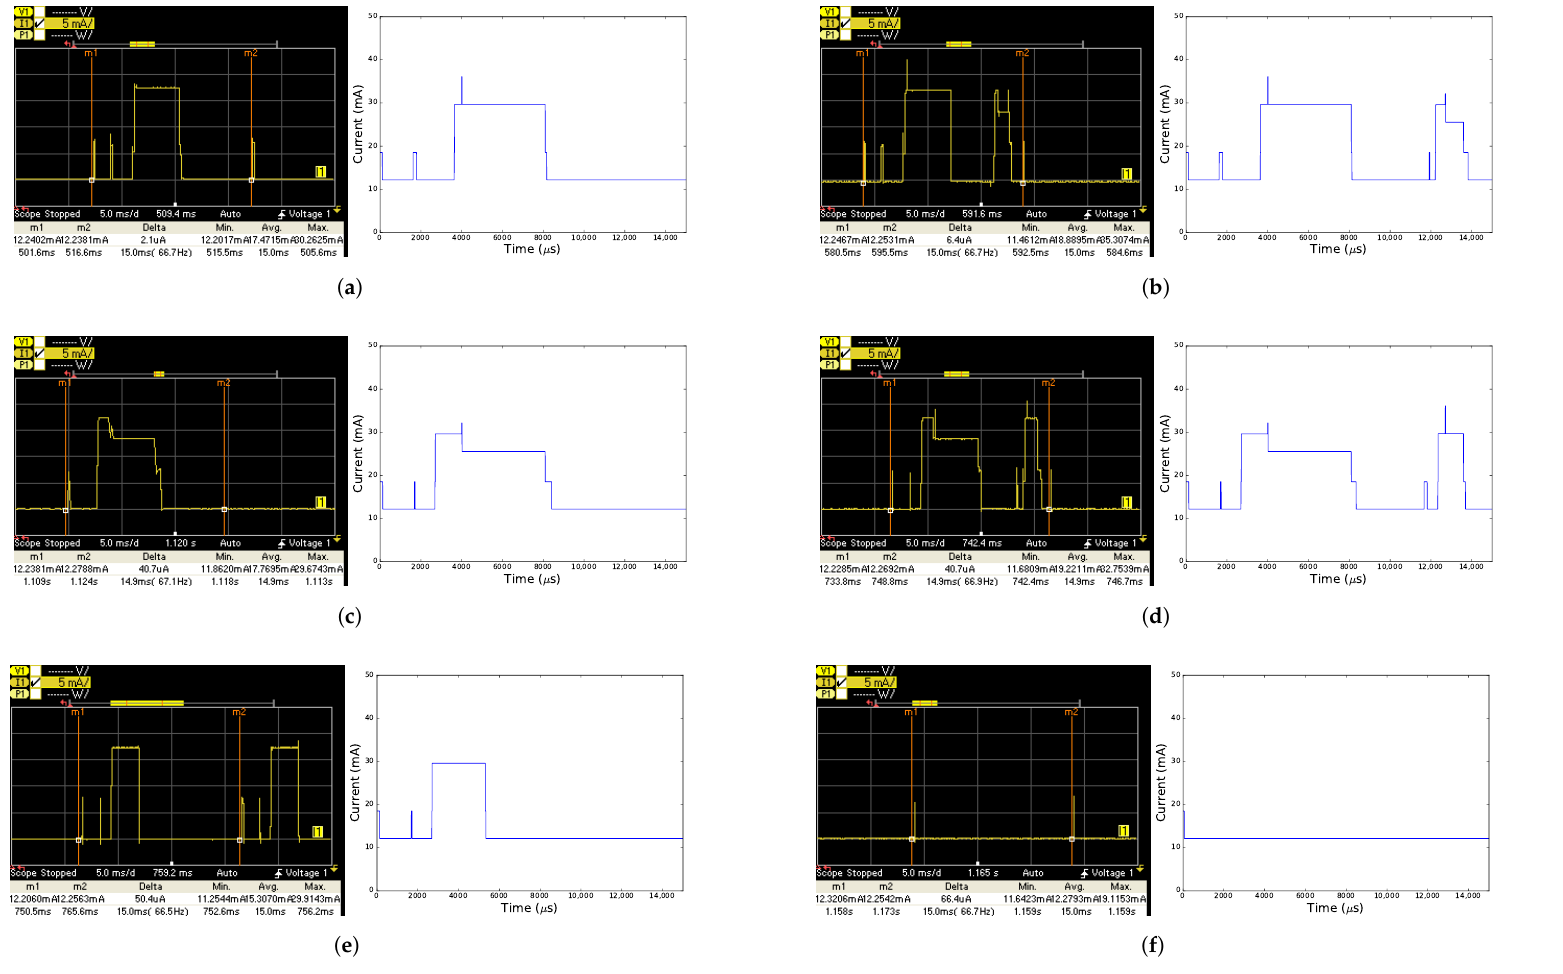
Figure 6. Measured (left, between vertical lines m1 and m2) and modeled (right) current comparison for each time slot when using the CC2538 radio. ( a ) TxData time slot; ( b ) TxDataRxAck time slot; ( c ) RxData time slot; ( d ) RxDataTxAck time slot; ( e ) RxIdle time slot; ( f ) Sleep time